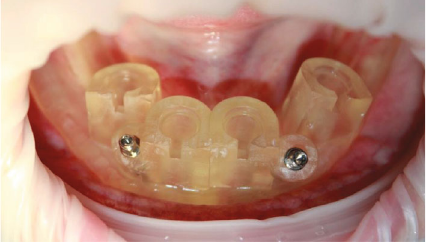
Figure 4: Fixed surgical guide.